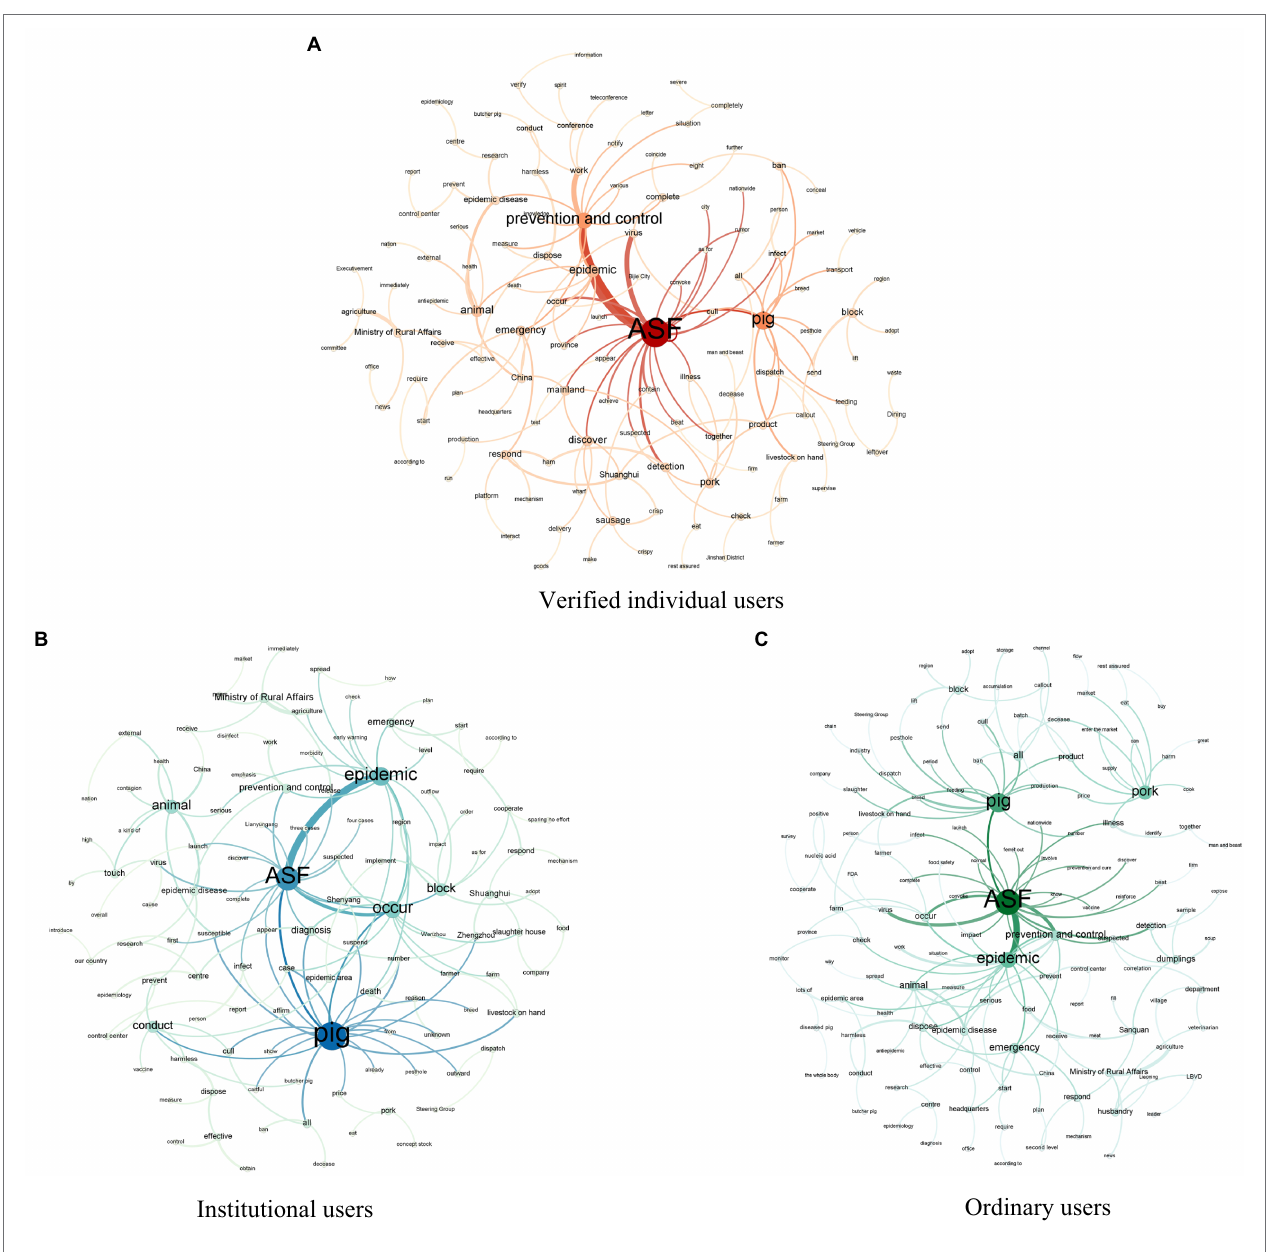
FIGURE 6 | Semantic association visualization for three types of